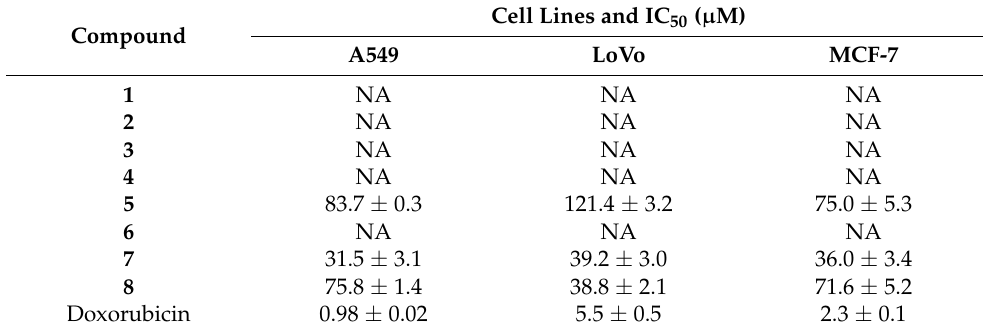
Table 3. Antiproliferative activity (IC 50 values) of compounds 1–8 against different cancer cells a . Compound